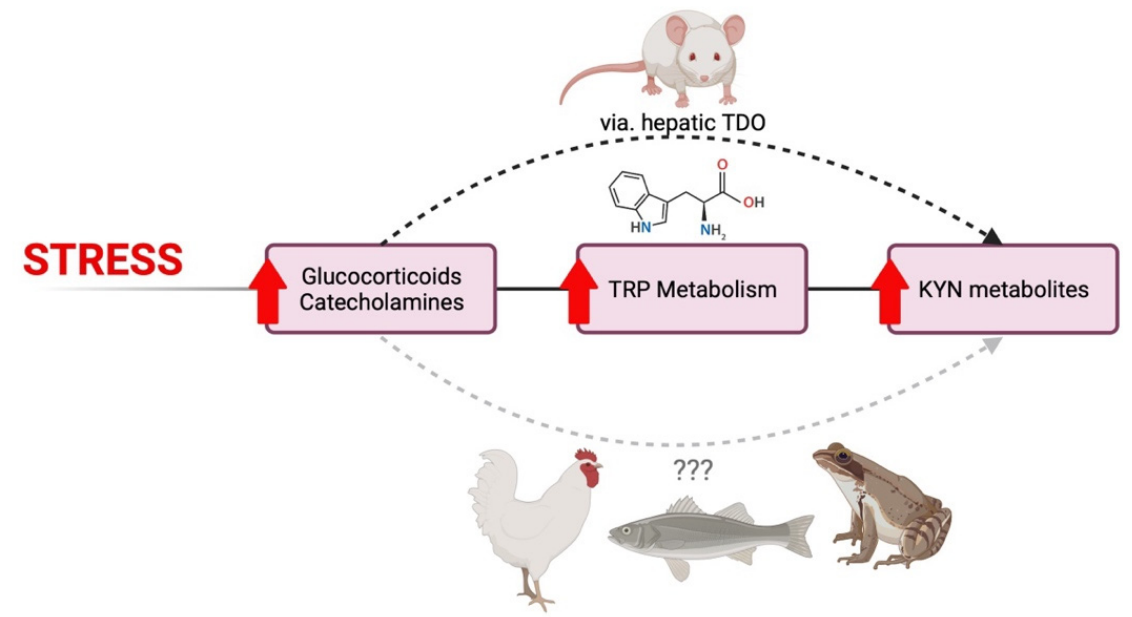
Figure 4. Across species, mammals, birds, and fish have similar responses to stress induced changes in TRP-KYN metabolism. Stress responses include increased GC and catecholamine signaling, which elevate TRP metabolism through the KYN pathway, as indicated by the levels of downstream metabolites. While it is generally accepted that this occurs through hepatic TDO induction in mammals, the molecular mechanism is not yet clear in other vertebrate species. Figure created on biorender.com.